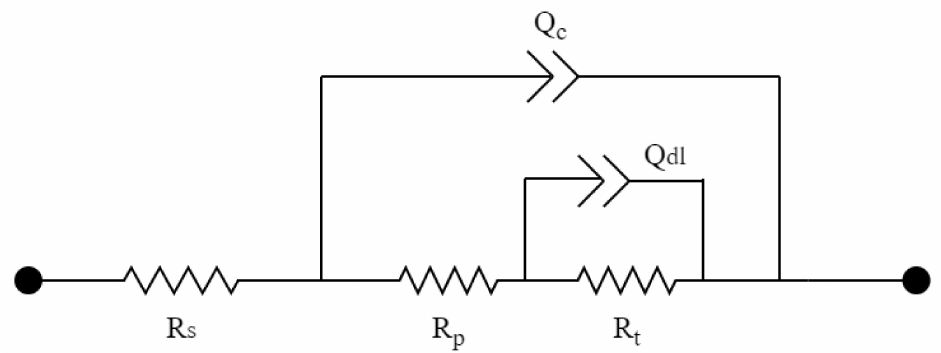
Figure 1. Equivalent circuit for fitting EIS data.